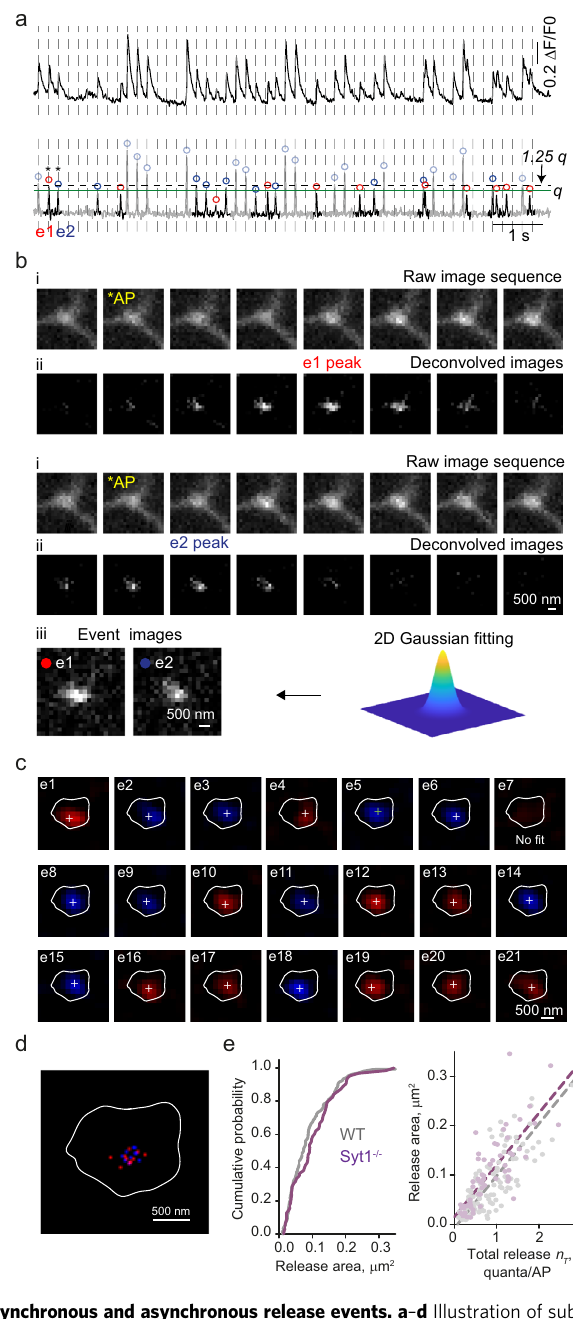
Fig. 5 Super-resolution localisation of synchronous and asynchronous release events. a – d Illustration of sub-pixel localisation analysis for single vesicle exocytosis events. a Raw (top) and deconvolved (bottom) SF-iGluSnFR traces from a representative bouton. Only single vesicle release events (black areas on the deconvolved trace) were included in the localisation analysis. These were selected using a 1.25 q amplitude threshold (dashed line), where q (green line) is the quantal size calculated as detailed in Fig. 1e. b Image pre-possessing in time domain. (i) Raw image sequences before and after event 1 (e1, asynchronous release, 3 frames after the preceding action potential, *AP) and event 2 (e2, synchronous release, 1 frame after the preceding action potential). (ii) Corresponding image sequences after pixel-by-pixel deconvolution of the unitary SF-iGluSnFR response. (iii) Event images, obtained by averaging 3 frames centred at the response peak on the deconvolved image stack used for subpixel localisation of release locations using 2D Gaussian fi tting (Methods). c Sub-pixel localisation (white crosses) of single quantal events selected in ( a ) (see also Supplementary Movie 2). Images are after application of a wavelet fi lter (Methods); e7 could not be localised due to a low signal-to-noise ratio. The bouton outline (white line) was determined by calculating maximal projection of the deconvolved image stack. d Composite image showing relative locations of synchronous (blue) and asynchronous (red) release events within a compact release area. ( e ) Distribution of release area sizes and their dependency on the overall release ef fi cacy in all boutons that passed the selection criteria for sub-pixel localisation (Methods, Data Inclusion and Exclusion Criteria) ( n = 106 boutons from N = 16 cells for wild type and n = 64 boutons from N = 11 cells for Syt1 − / −